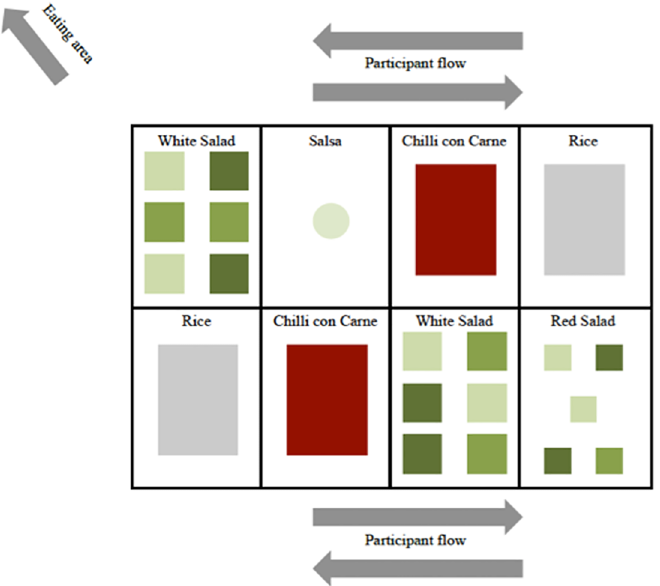
Fig 4. Visual presentation of the experiment setting: Perceivedvariety. The salad was split up to its component,increasingthe visual variety and allowingparticipants to compose their own salad.